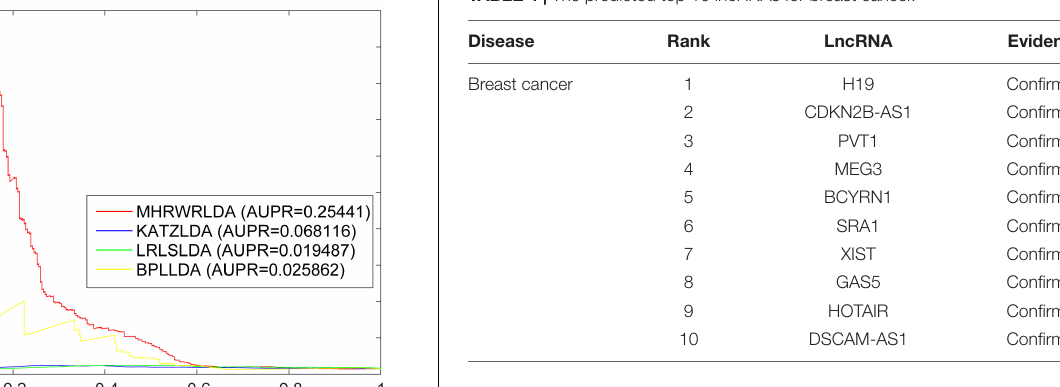
TABLE 4 | The predicted top 10 lncRNAs for breast cancer.